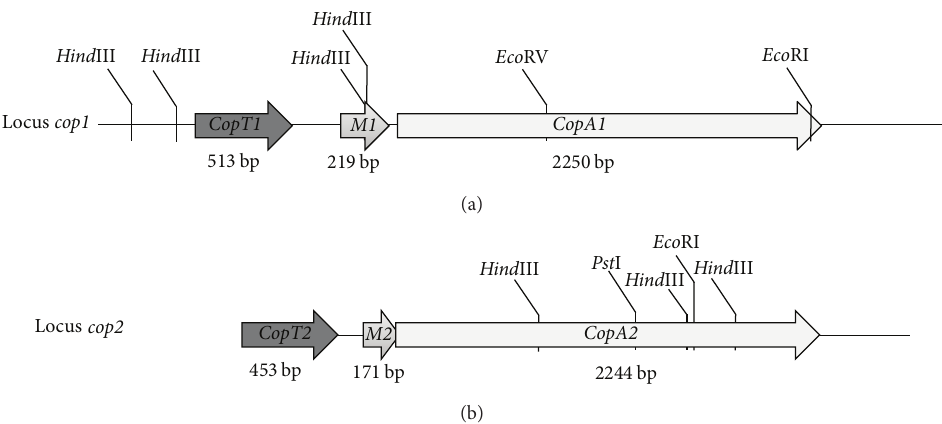
Figure 5: Schematic representation of the two cop gene clusters isolated from S. metallicus genome. Each cluster codes for an Archaea -specific transcriptional regulator ( copT ), a metallochaperone ( copM ), and a P-type Cu-exporting ATPase (copA ). Lengths of each gene are indicated. Locus cop1 corresponds to 4,346 sequenced base pairs and shows an intergenic region copT1-M1 of 232 base pairs. Locus cop2 corresponds to 3,435 base pairs and shows 89 base pairs copT2-M2 intergenic region. Genes copM2 and copA2 overlapped in 11 base pairs. copT2 was not fully isolated.